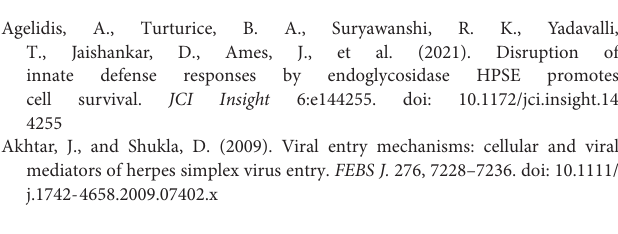
Supplementary Figure 1 | Actin depolymerizing agent Cytochalasin D (Cyto D) significantly affects HCMV entry into HIS cells. In this experiment, HIS cells either mock-treated (A) and or pre-treated with Cyto D (1.0 µ g/ml: B ) for 1 h before challenging with HCMV (10 MOI) for additional 2 h. The cells were then fixed and washed for immunofluorescence staining using anti-HCMV gB antibody for the virus detection using Nikon A1R confocal imaging at 40 × . A high-affinity F-actin probe rhodamine phalloidin conjugated to red fluorescent dye was used for the detection of actin cytoskeleton, while DAPI was used for nucleus staining. The region boxed in (A) is further highlighted in (a–c) showing the presence of HCMV particles on the sprouting filopodial antennas. Supplementary Figure 2 | Enzymatic expression of 3-O-sulfotransferase-3 (3-OST-3) results in the entry of herpes simplex virus type-1 (HSV-1) into resistant CHO-K1 cells. CHO-K1 cells were grown in six-well plates to subconfluence and transfected with 2.0 µ g of human encoded 3-OST isoform (3-OST-3B1), or with an empty vector (pCDNA) using lipofectamine 2000. At 16 h post-transfection, the cells were replated into 96-well dishes for infection with recombinant virus HSV-1 (KOS) gL86 at the 10 MOI. After 6 h postinfection, β -galactosidase assays were performed using either a soluble substrate o-nitrophenyl- β -D-galactopyranoside (ONPG; ImmunoPure, Pierce) at 3.0 mg/ml. The enzymatic activity was measured at 410 nm using a microplate reader. Viral entry corresponds to expression of 3-O sulfated HS receptor. Asterisks indicate significant difference from controls and/or treatments ( n = 3; P < 0.005, Student’s t -test) and error bars represent SD. Supplementary Figure 3 | The expression of HCMV glycoprotein B (gB) in CHO-K1 cell. In this experiment, CHO-K1 cells were transfected with the expression plasmid encoding HCMV gB and or an empty vector (pCDNA) using lipofectamine 2000 for 16 h. The cells were then washed with 1 × Tris-buffered saline followed by methanol fixing. The gB detection was done using monoclonal antibody to HCMV gB and goat anti-mouse peroxidase conjugated secondary antibody followed by rinsing and adding the substrate 3,3 (cid:48) ,5,5 (cid:48) -tetramethyl- benzidine (TMB). The enzymatic activity was measured at OD 450 nm by a microplate photometer (Thermo Fisher Scientific Multiskan FC). Asterisks indicate significant difference from controls and/or treatments ( n = 3; P < 0.005, Student’s t -test) and error bars represent